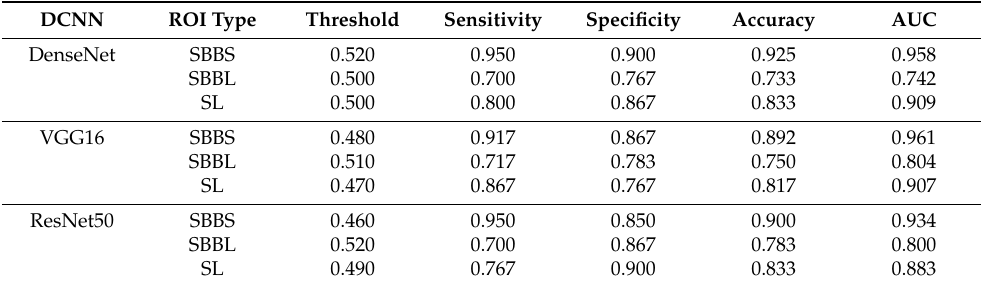
Table 4. Performance of BC classification of five DCNNs on testing subsets with different kinds of ROIs based on the average